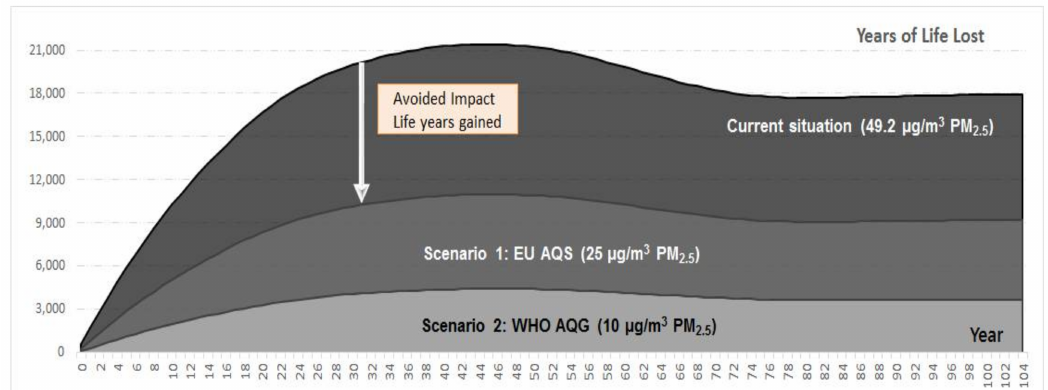
Figure 1. Health burden in terms of YLL and potential benefits under different mitigation scenarios.